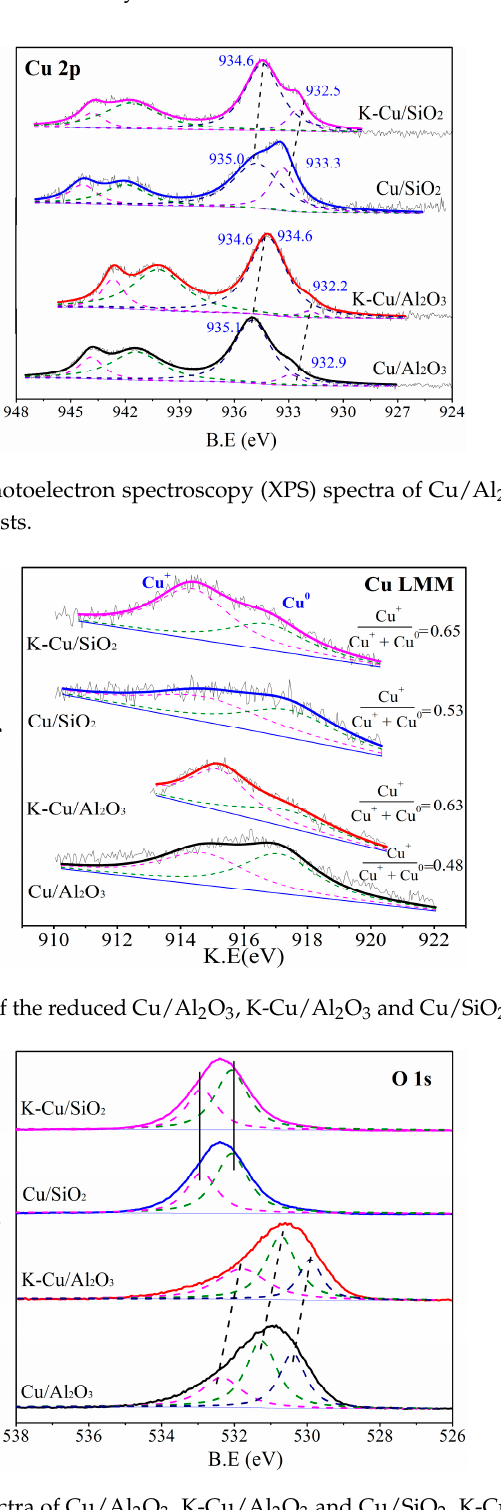
Figure 7. O1s XPS spectra of Cu/Al 2 O 3 , K-Cu/Al 2 O 3 and Cu/SiO 2 , K-Cu/SiO 2 catalysts .